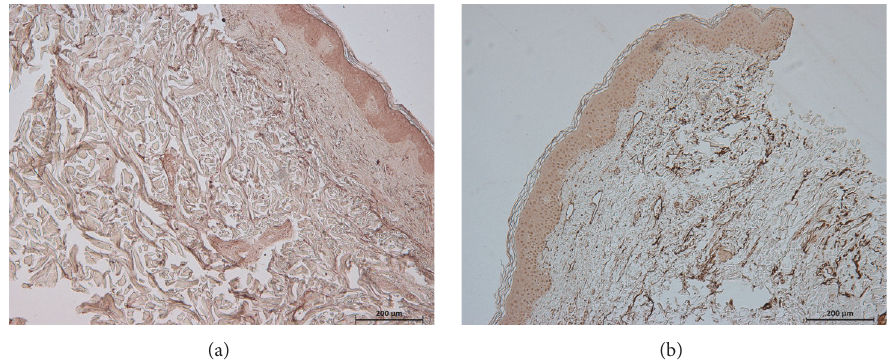
Figure 2: The degree of destruction of elastic fibers was greater in the protruding type than the indented type. (a) Protruding anetoderma lesions; (b) indented anetoderma lesions (elastin, original magnification: × 100).